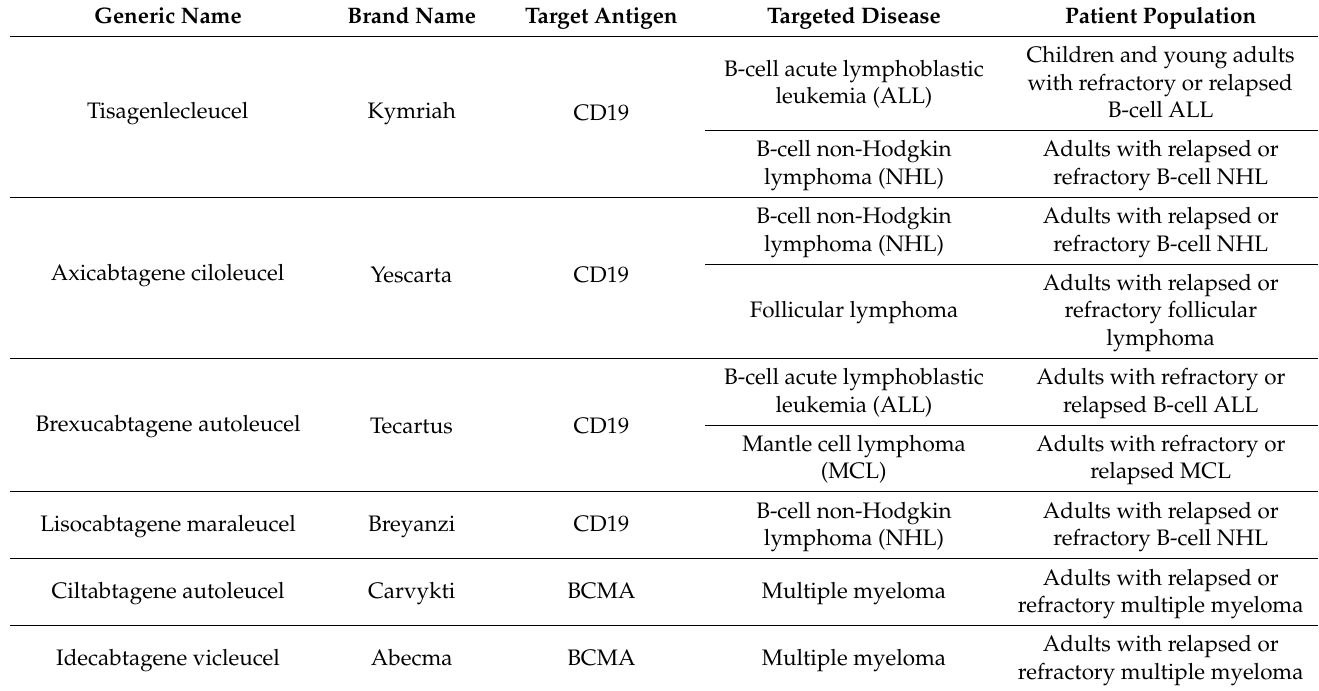
Table 1. CAR-T-cell therapy approved by FDA [43–49].